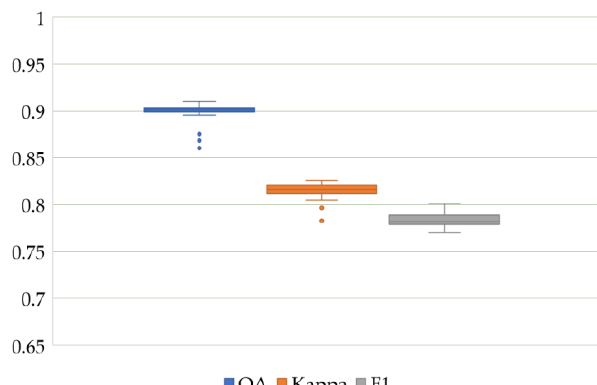
Figure 3. Variability of overall accuracy (OA), Kappa coefficient and F1 score for the flat classification —result of 100 iterations run over the 34UCC granule. The box plot indicates outliers, first quartile, median, third quartile and maximum values.